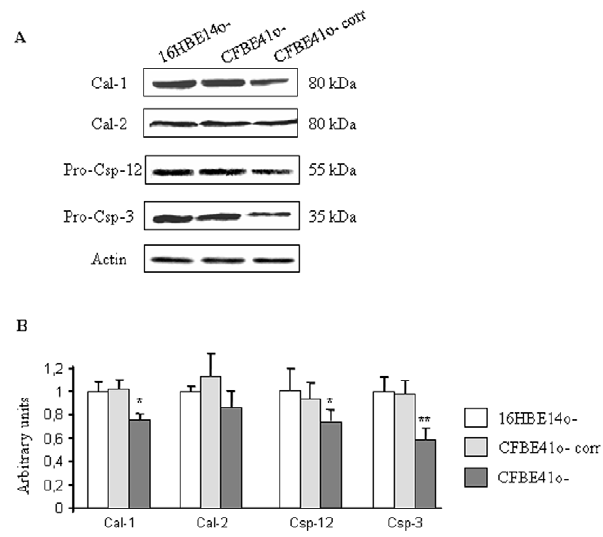
Figure 2. Expression of Cal-1, Cal-2, Csp-12 and Csp-3 in 16HBE14o-, CFBE41o- corr and CFBE41o- cells. A. Example of western blots showing the expression of Cal-1, Cal-2, pro-Csp-12, pro- Csp-3 and actin in 16HBE14o-, CFBE41o- corr and CFBE41o- cells. B. Histograms represent the quantification of Cal-1, Cal-2, pro-Csp-12 and pro-Csp-3 in 16HBE14o-, CFBE41o- corr and CFBE41o- cells The statistical analysis indicates a significant decreased of Cal-1, pro-Csp- 12 and pro-Csp-3 in CFBE41o- cells. Bars represent SEM (n=7).